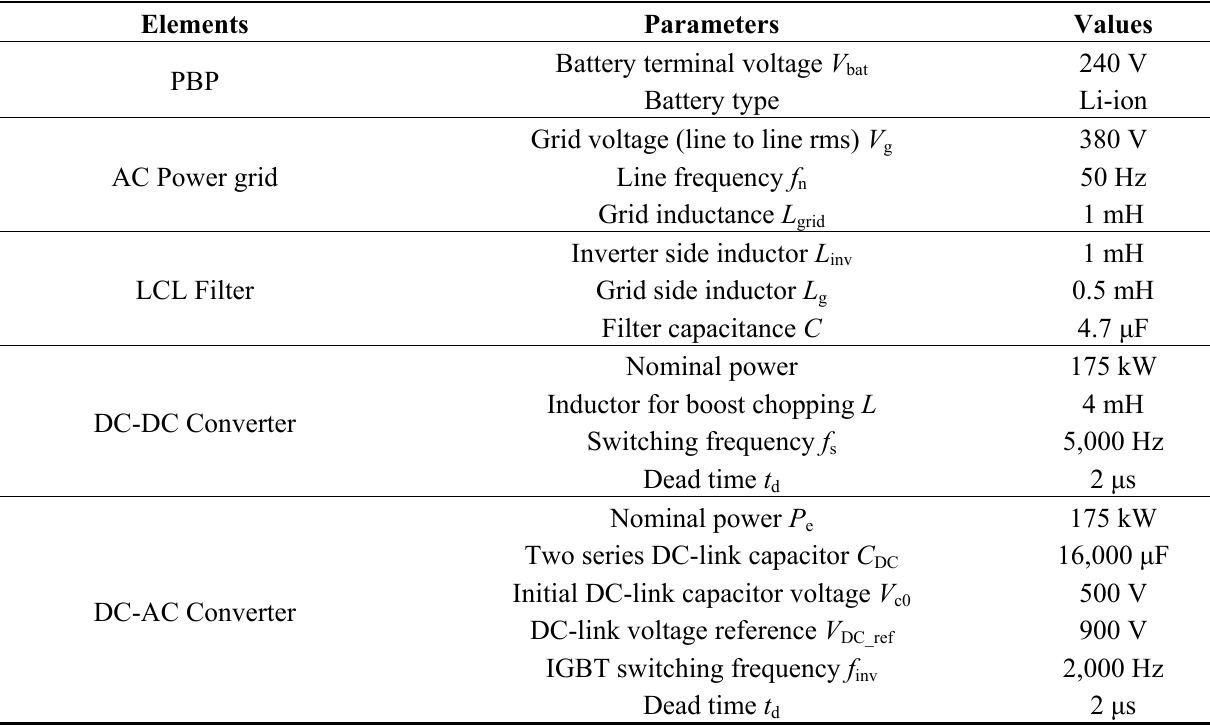
Table A2. Specifications adopted for the proposed ERPABPTS under discharging mode. PBP: power battery